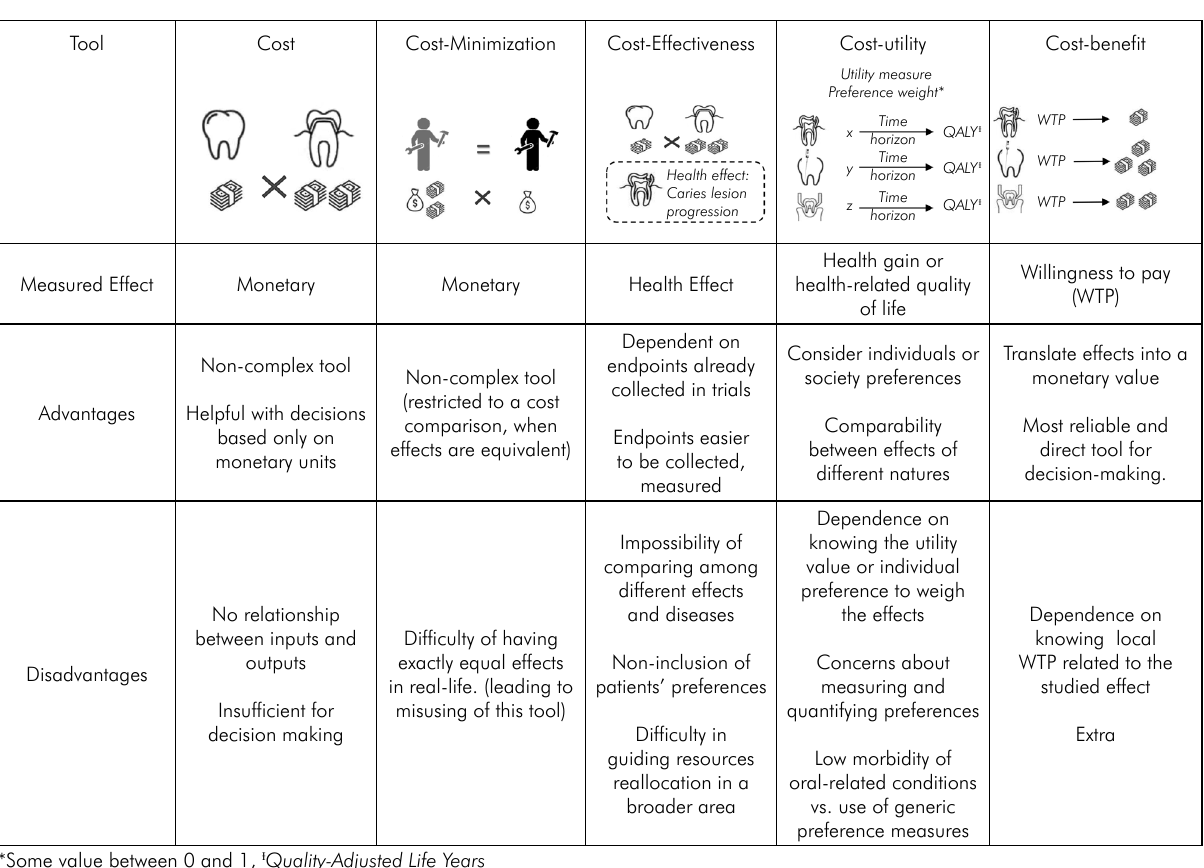
Figure 2. Different types of economic evaluations and different effects supposed to be measured when conducting